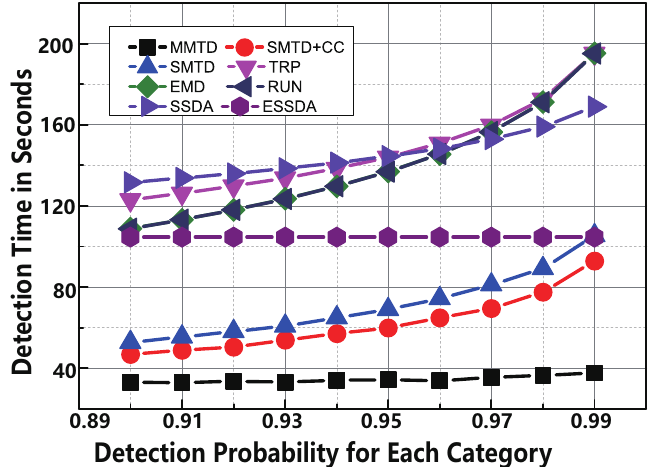
Figure 10. The comparison of time-efficiency between MMTD and other missing tag detection protocols when α i is set to be from 0.9 to